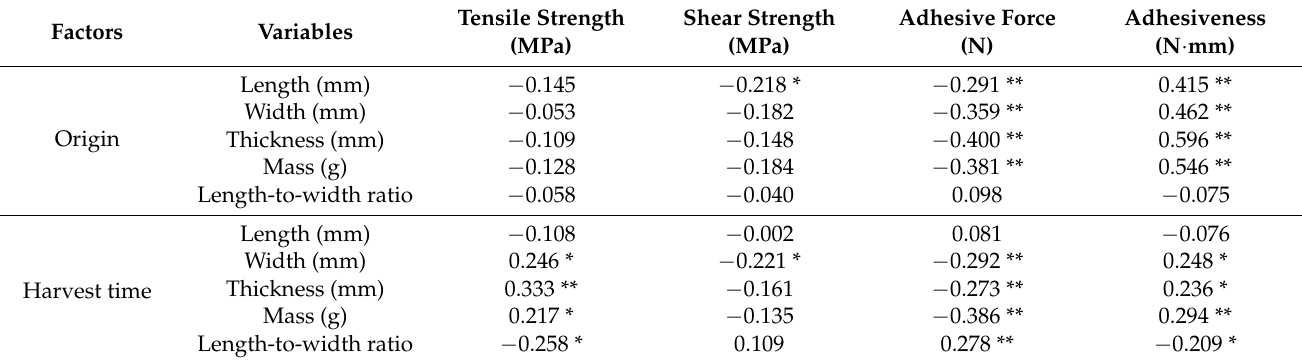
Table 2. Correlation coefficients between biological and mechanical